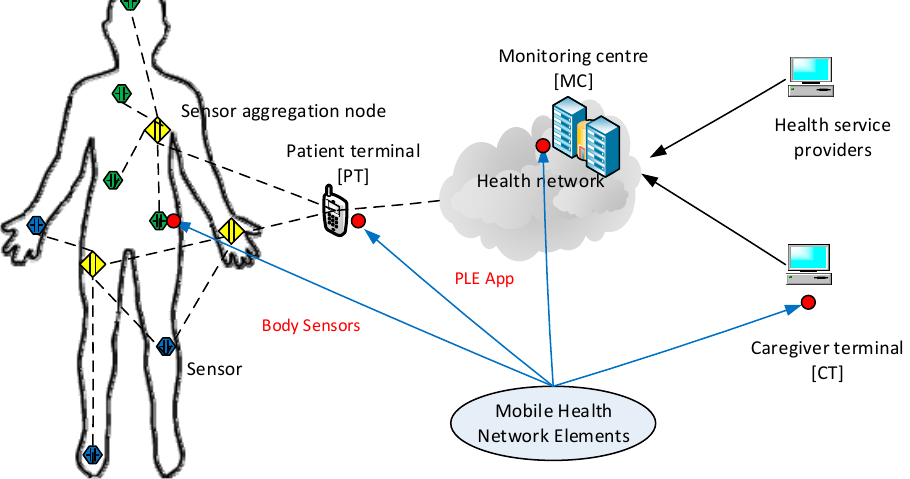
Figure 8. Mobile health (mHealth) network, which consists of WBAN, Health service providers, Caregiver network and central cloud